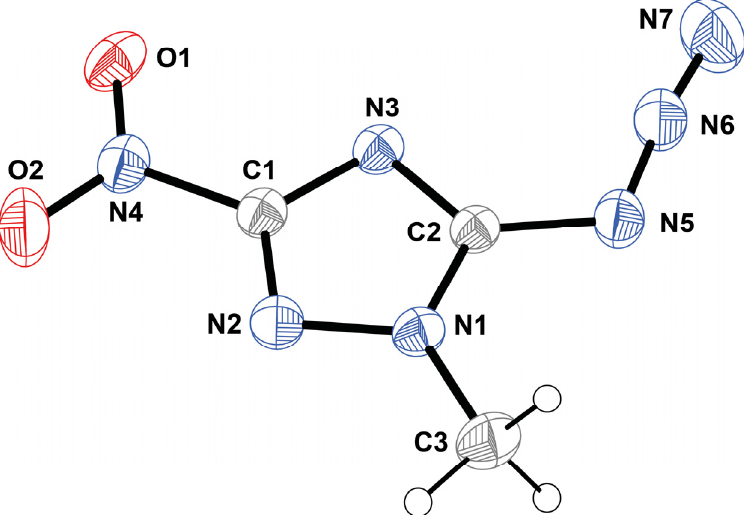
Figure 4. Molecular structure of 5-azido-1-methyl-3-nitro-1,2,4-triazole ( 2